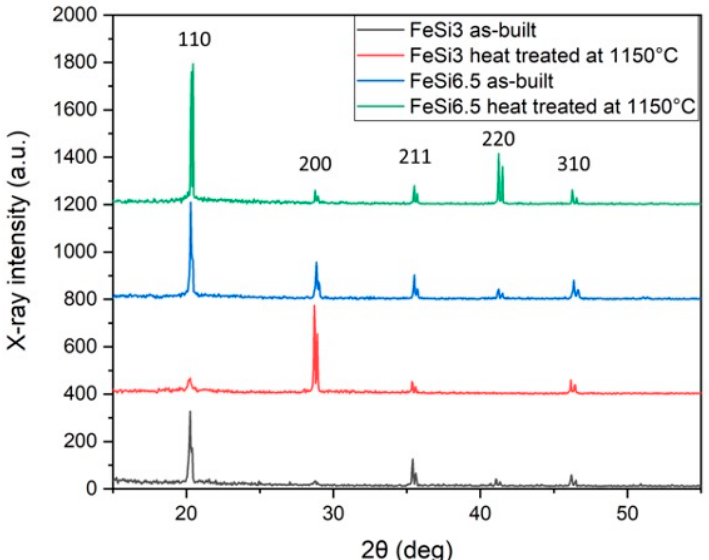
Figure 11. XRD spectra of FeSi3 and FeSi6.5 steels samples, in as-built condition and after heat treatment at 1150 °C for one hour.